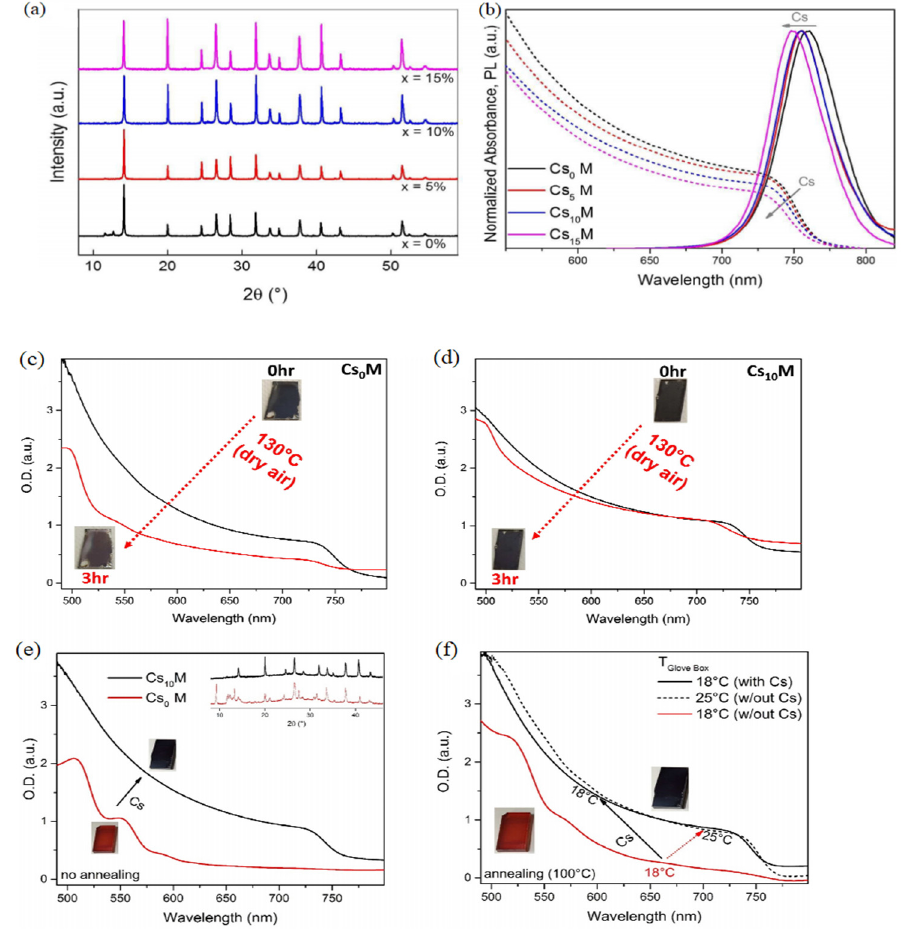
Figure 1. Different spectrum of perovskite with different amounts of Cs ( a ) XRD, ( b ) Absorbance and PL spectra; UV–vis absorption of ( c ) Cs 0 M and ( d ) Cs 10 M films which were annealed at 130 °C for 3 h in dry air; ( e ) absorption spectra of as-fabricated materials which were not annealed at room temperature. The perovskite characters of Cs 10 M can be shown in the inset XRD data; ( f ) absorption spectra showed perovskite phase of Cs 0 M formed at 25 °C (dashed black line) and perovskite phase of Cs 10 M formed at 18 °C (solid black line) by using the spin coating. Reprinted with permission from Ref. [40]. Copyright 2016 Royal Society of Chemistry.